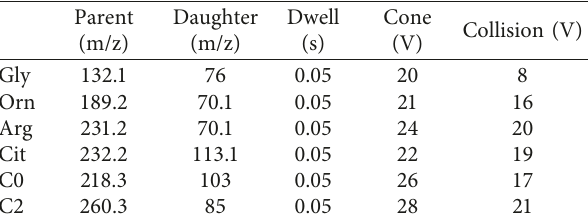
Table 1: Multiple reaction monitoring scan mode mass spec- trometry parameters.